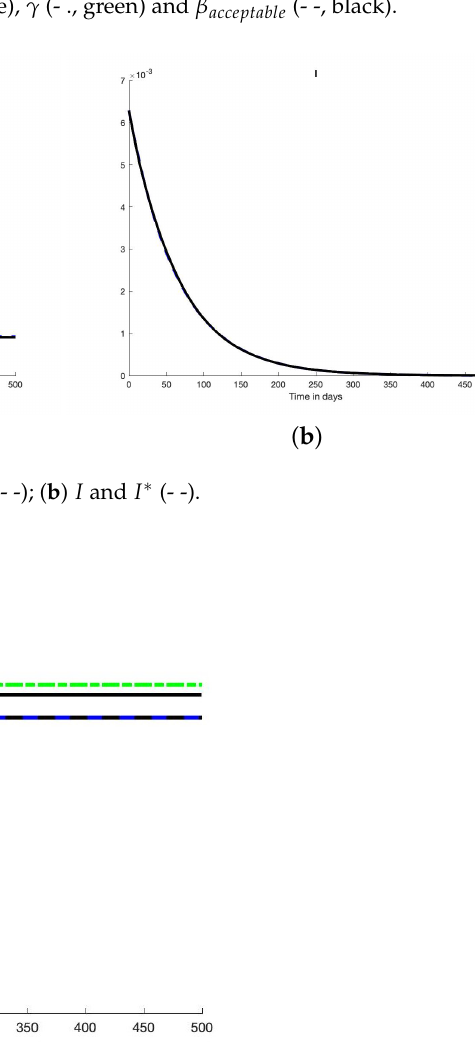
Figure 9. Scenario 5: Control. β , β ∗ (- -,blue), γ (- ., green) and β acceptable (- -, black).